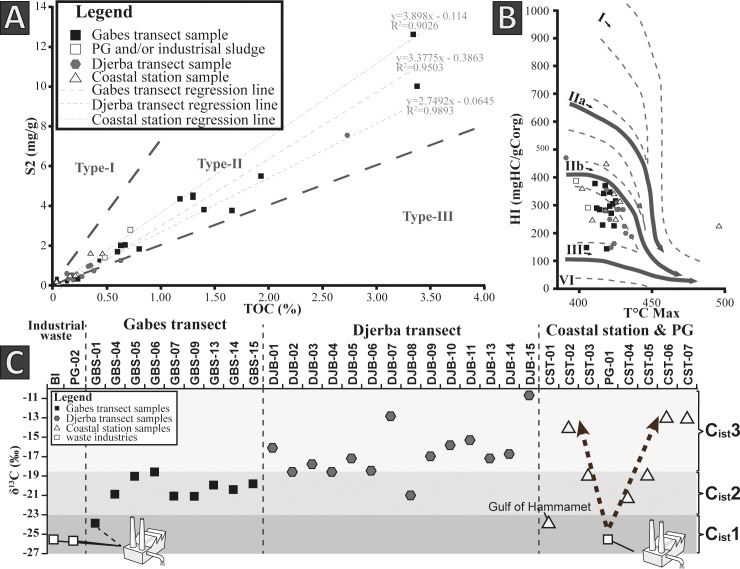
Origin of organic matter from surface sediments in the Gulf of Gabes.(A) S2 versus TOC diagram. (B) HI versus T max diagram. (C) The three clusters based on OM δ13C value.